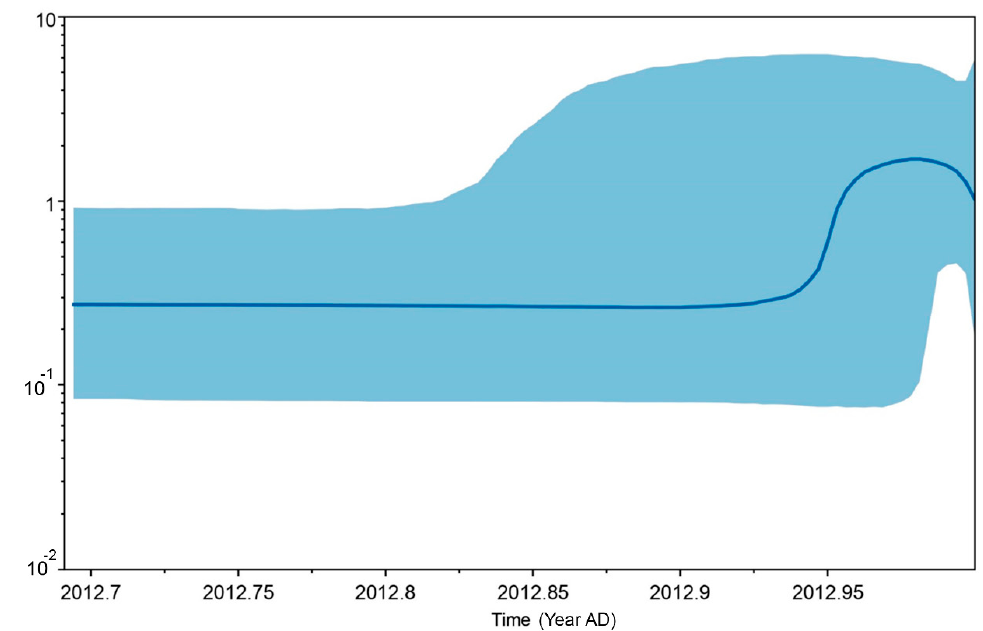
Figure 3. Coalescent Bayesian Skyline analysis output. The black line is the median estimated effective population size. The blue areas represent the upper and lower bounds of the 95% higher posterior density interval. The x -axis is time in years and the y -axis is a log scale.